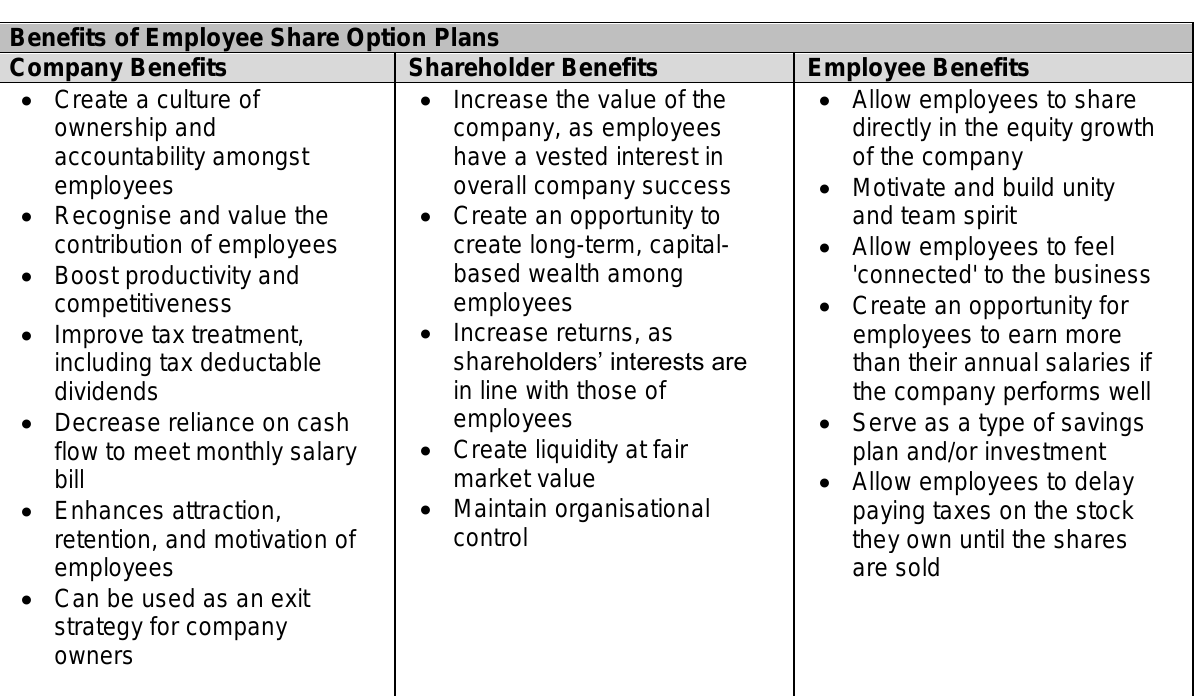
Table 1. Benefits of ESO